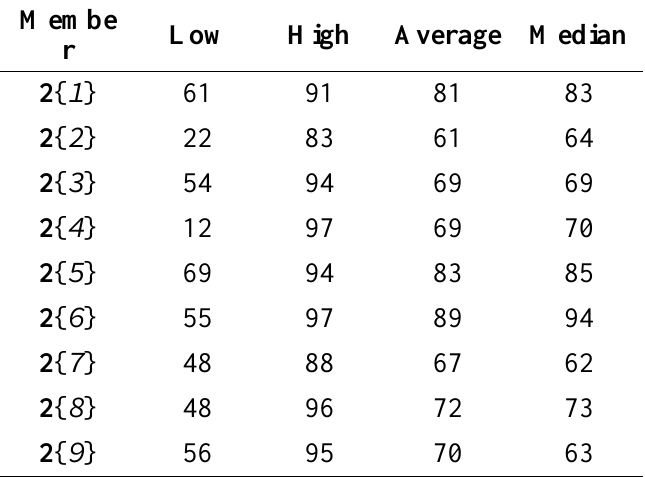
Table 4. Percent yields of purified library members based on amino acid esters, 2